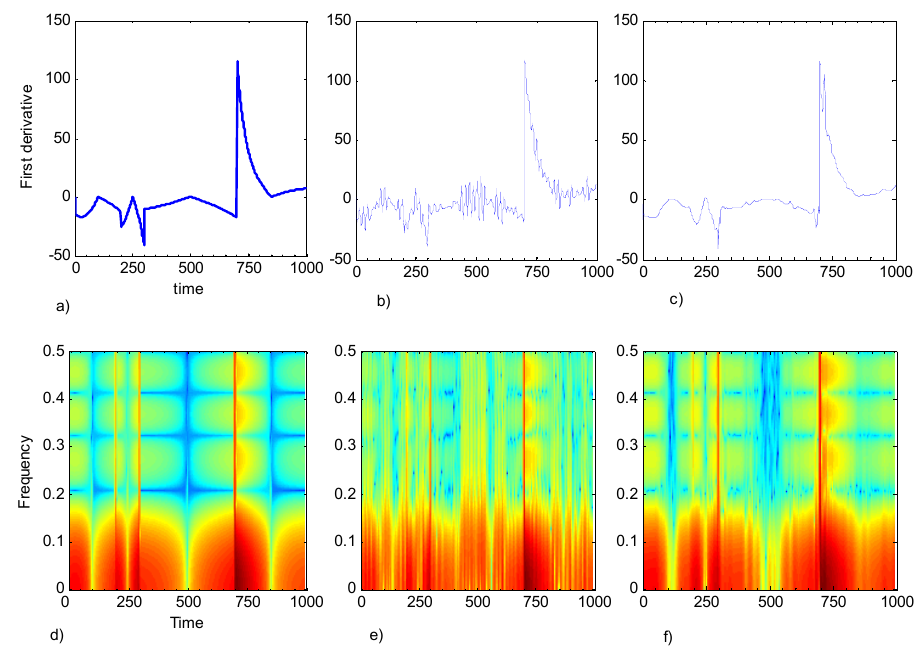
Fig. 5. a) Synthetic signal representing a secular variation-like signal (top panel, left) composed by first differences (first derivative) of several exponential spikes; b) Composed signal by the above synthetic signal and a colored noise; c) The de-noised signal of the composed signal (b). The units of the signal, its derivative and time are arbitrary. Bottom panel, the spectrograms (d-f) of the respective signals (a-c).